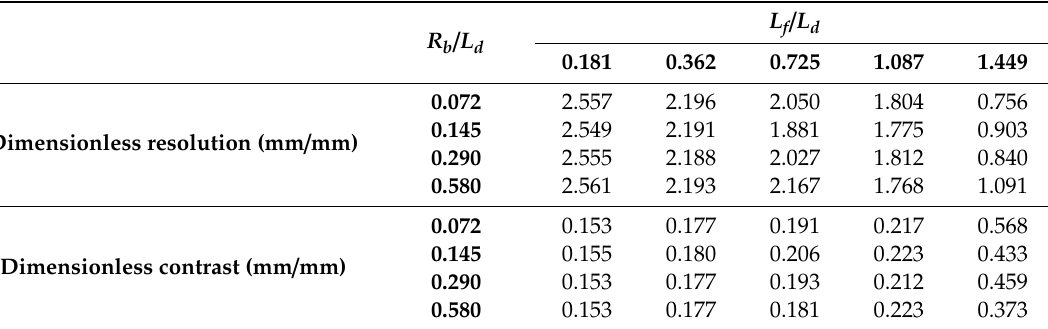
Table 5. Image quality depending on changes in L f and R b .